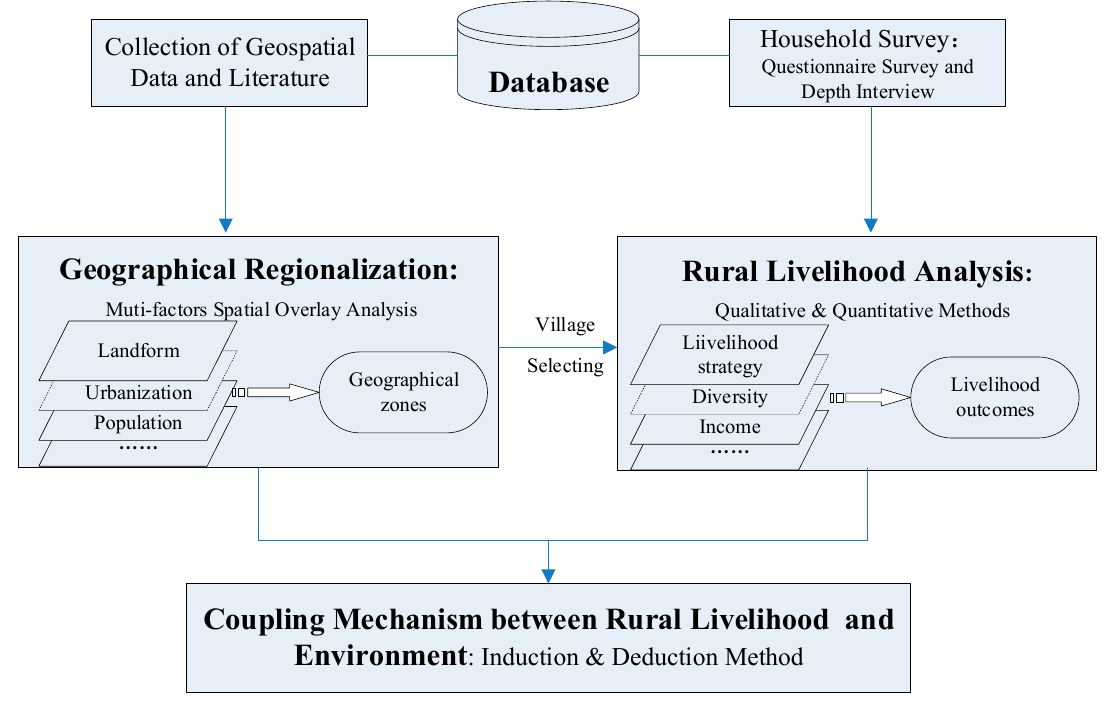
Figure 2. Methodological framework for rural livelihood–environment nexus analysis.